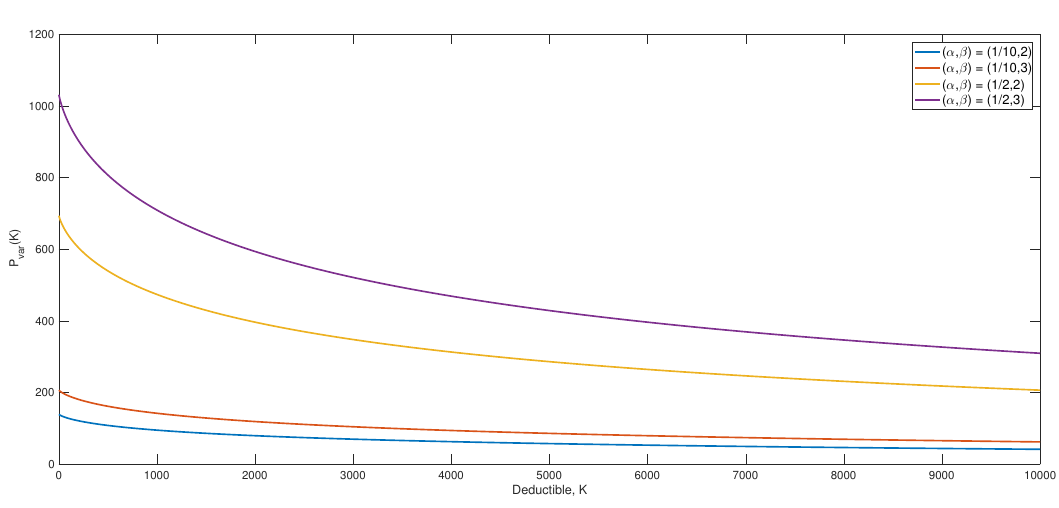
Figure 1. The premium (14) as function of K for different values of customer characteristics. The interest rate is chosen to be 2%, and the estimates ˆ µ = 1.6 and ˆ σ = 1.99 are